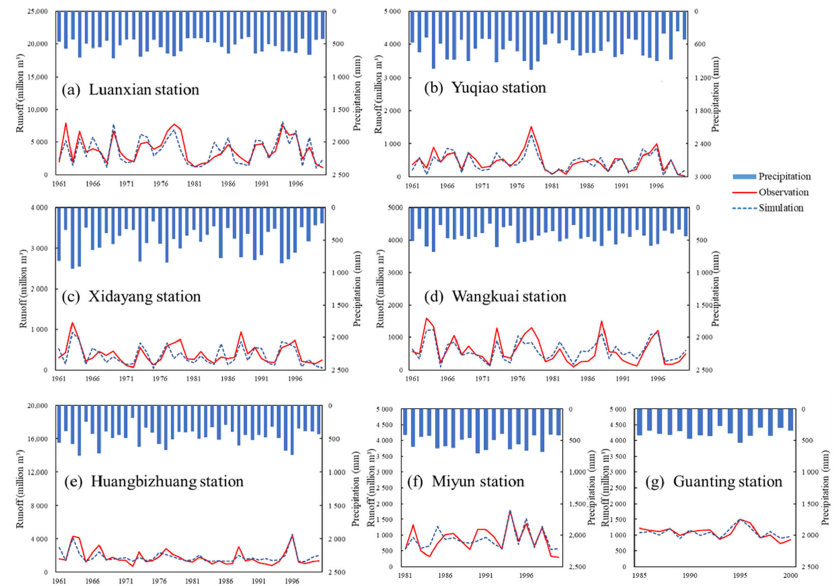
Figure 6. Comparison of annual precipitation and simulated and observed runoff during the calibration and validation periods at seven runoff stations.